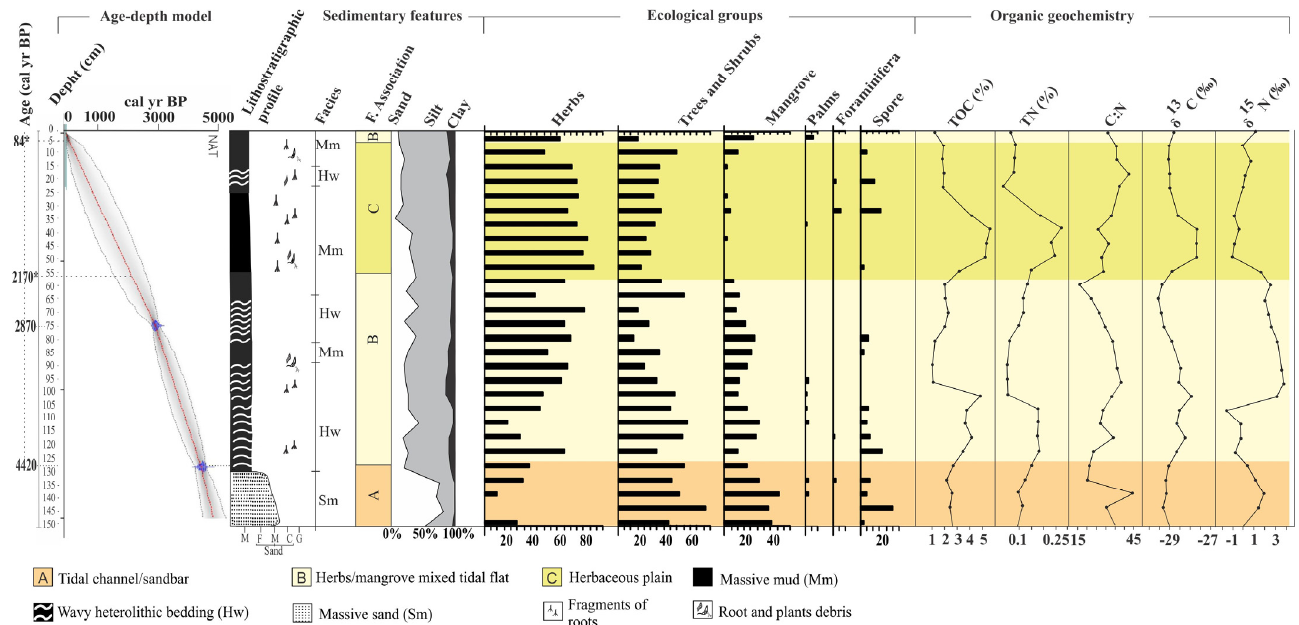
Figure 4. Summary results for core NAT − 5, with variation depending on the depth of the core, showing chronological and lithological profiles with sedimentary facies, as well as ecological groups of pollen and geochemical variables. Pollen data are presented in the pollen diagrams as percentages of the total pollen sum.